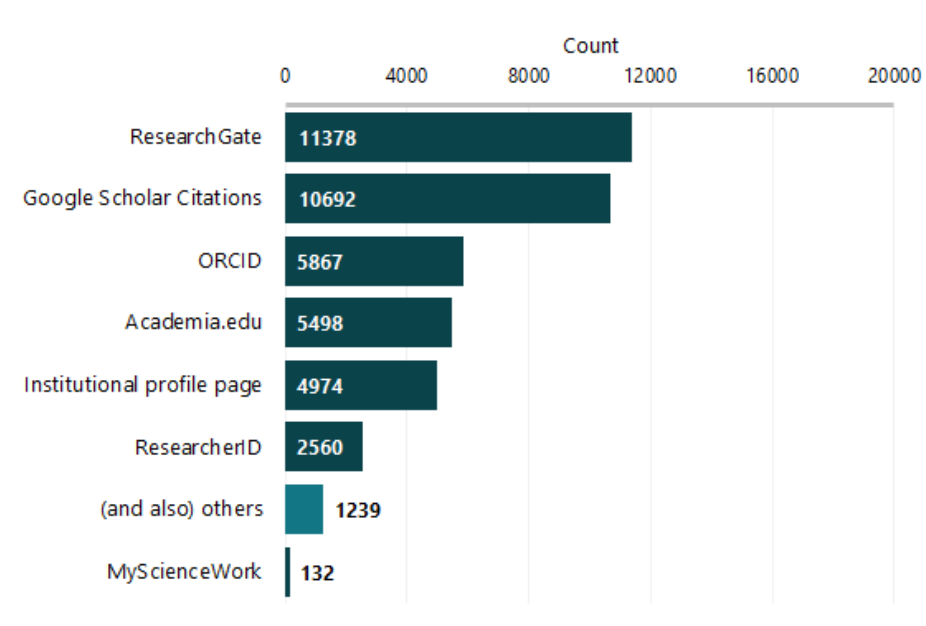
Figure 8: Fragment from the survey results for Researcher profiles (source: https://101innovations.